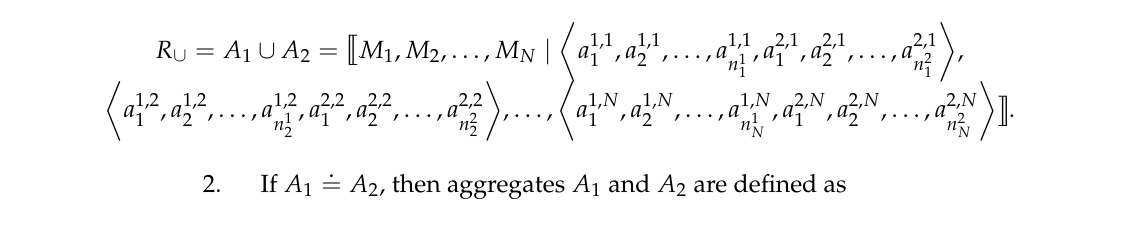
Figure 1. An example of two compatible aggregates.